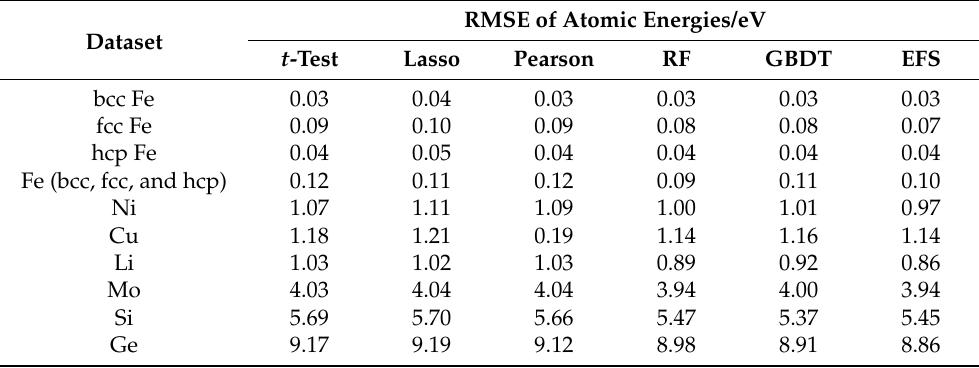
Table 7. Force RMSE comparison between EFS and benchmark methods on qSNAP. RMSE of Atomic Forces/eV/Å t -Test